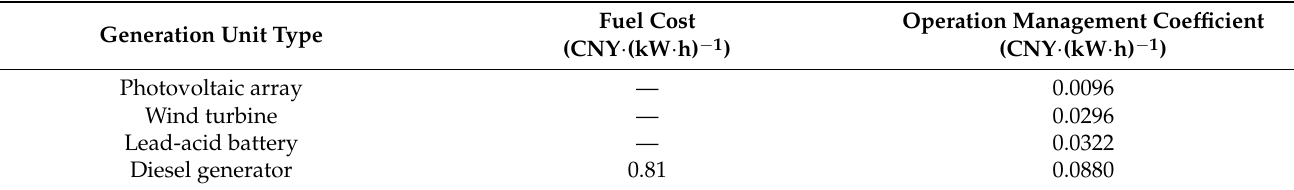
Table 2. Cost coefficient of each distributed generation.